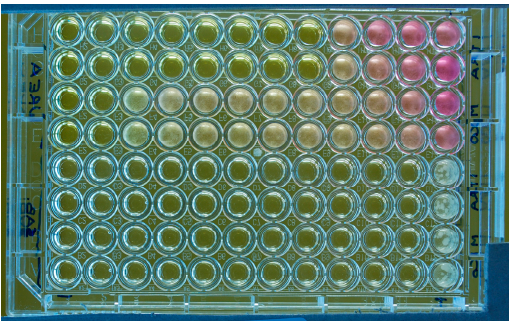
Figure 1. Microtitre plate (flat-bottom wells) illustrating susceptibility testing of a M. pachydermatis isolate against two antifungal drugs (ITZ: rows 1–2 and 5–6 and MCZ: rows 3–4 and 7–8) tested in duplicate with two different media (Urea Christensen Broth with Tween 40 and 80 as lipid source, rows 1–4; lipid-free Sabouraud broth, rows 5–8). The last column on the right comprises the drug-free growth controls. The last column on the left is the negative control (no yeast inoculum; no drug). The rows of wells contain doubling dilutions of the drugs from 4 to 0.007 µg/mL with the highest concentration to the left of the plate. For this experiment, the MICs were 0.06 (ITZ) and 4 (MCZ) µg/mL if tested in the lipid-supplemented broth; or 0.007 µg/mL for both drugs if tested in the lipid-free broth. In this latter medium, a yeast growth is visible only in the control wells. A partial color change due to the urease activity of the yeast and consequent rise of pH, is visible in some wells. It can be also noted that the yeast produced a diffuse turbidity in the wells.